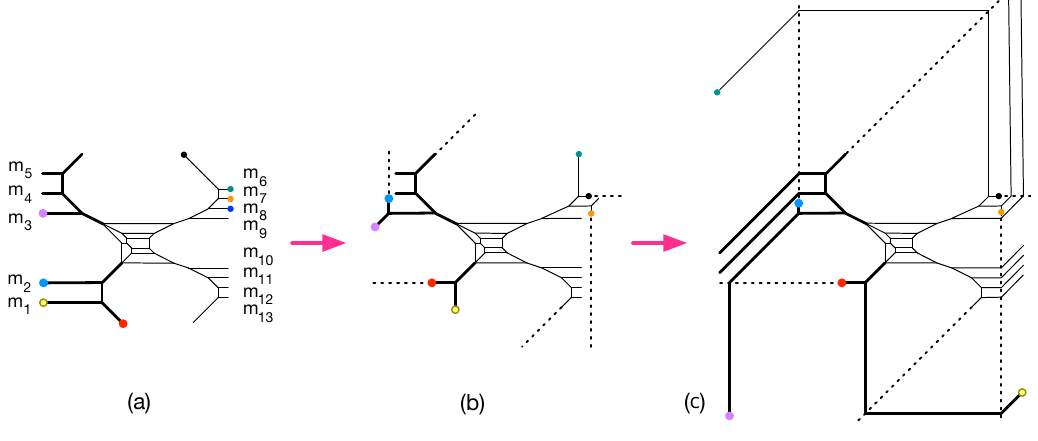
Figure 18 . SU(6) 0 + 1